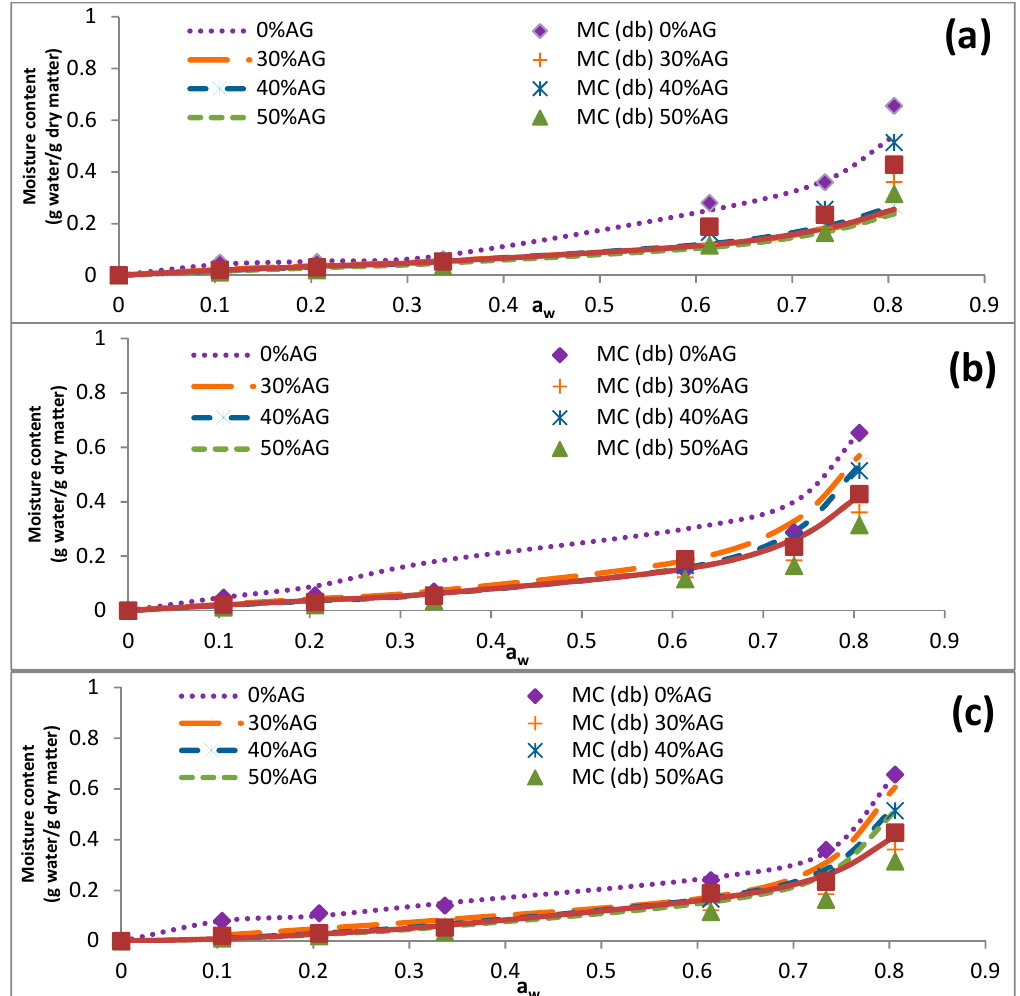
Figure 3. Effects of acacia gum concentration on the equilibrium moisture sorption isotherm of date syrup powders at 40 °C. The experimental data are presented as symbols and the data obtained by fitting experimental data into mathematical models are presented as lines. ( a – c ) represent the obtained data from BET, GAB, and Peleg models. 0% AG: 100% DS-0% AG; 30% AG: 70% DS-30% AG; 40% AG: 60% DS-40% acacia gum; 50% AG: 50% DS-50% AG; 60% AG: 40% DS-60% acacia gum; DS: date syrup; AG: acacia